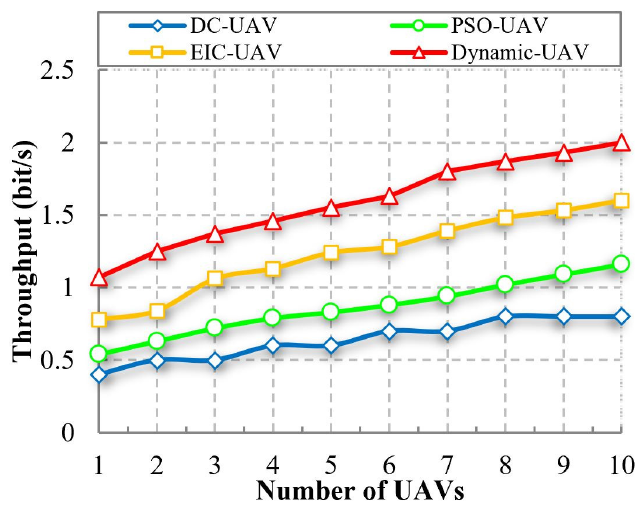
Figure 8. Number of UAVs vs.